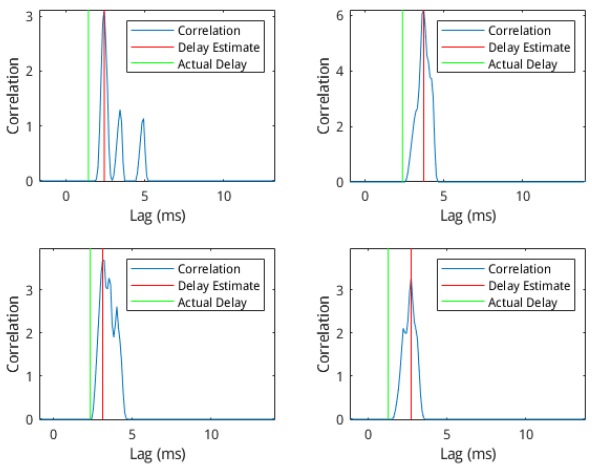
Figure 5. Comparison of 2-cell cross-correlation with delay estimate. Cross-correlation shown in black, estimated delay as a vertical red line, actual delay as a vertical green line.